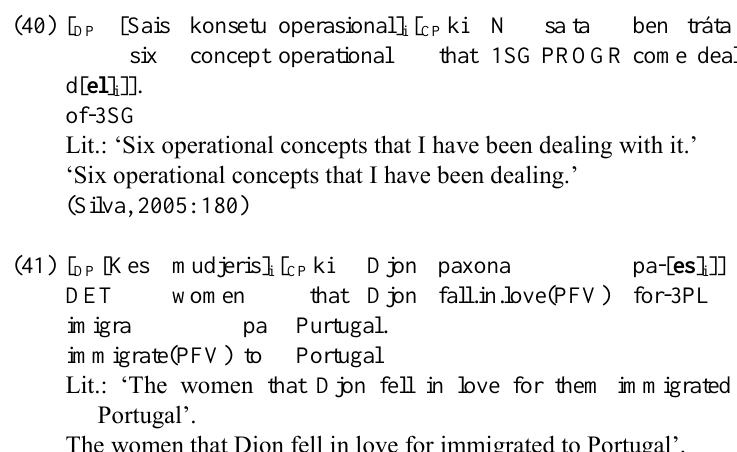
Djon po jaru tene